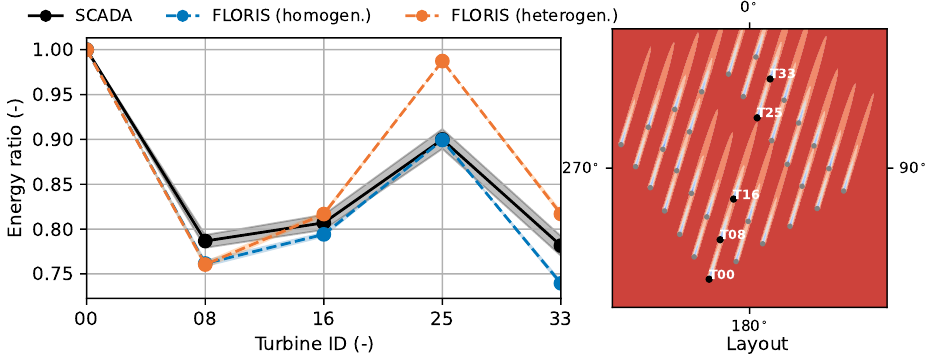
Figure 14. Energy ratios of Turbines 0, 8, 16, 25, and 33 for the Westermost Rough wind farm for a narrow wind direction sector of 189.5 ◦ to 204.5 ◦ . Turbine 0 acts as the reference turbine, and the reference wind direction is the average of the wind direction measurements of the array of turbines. The shaded regions represent 90% confidence interval bounds obtained through bootstrapping. The layout schematic on the right shows the location of Turbines 0, 8, 16, 25, and 33 in the wind